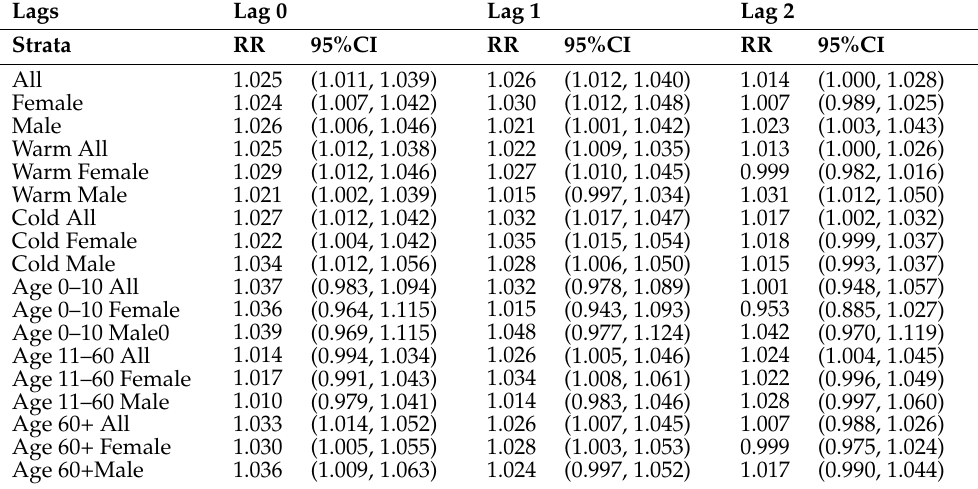
Table 3. Estimated relative risks (RR) and their 95% confidence intervals (95%CI) for an increase in the AQHI level by a one interquartile range (IQR = 1.0). ICD-10 codes: D50–D89; Chapter III Diseases of the blood and blood-forming organs and certain disorders involving the immune mechanism. Data recorded in Toronto, Canada for the period between April 2004 and December 2015. Lags Lag 0 Lag 1 Lag 2 Strata RR 95%CI RR 95%CI 95%CI